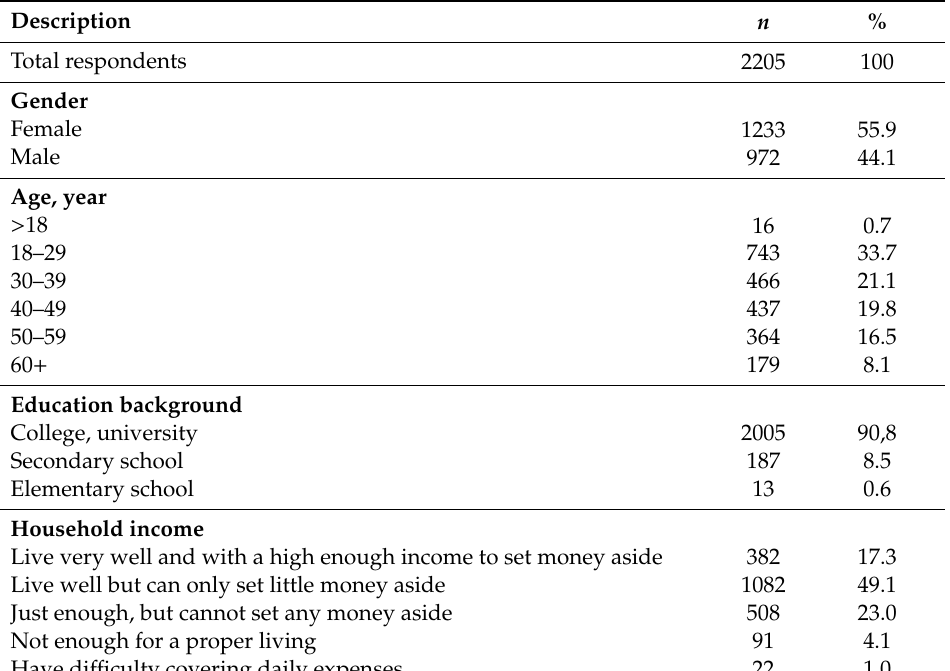
Table 1. The distribution of the